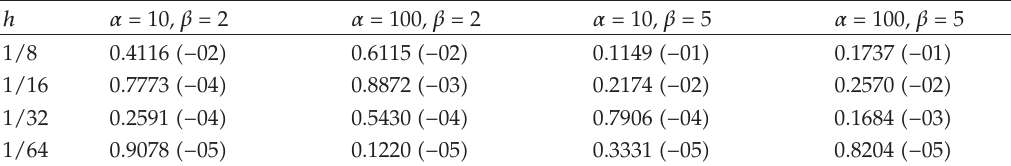
Table 9: RMS errors of the scheme in (cid:6) 32 (cid:7) .